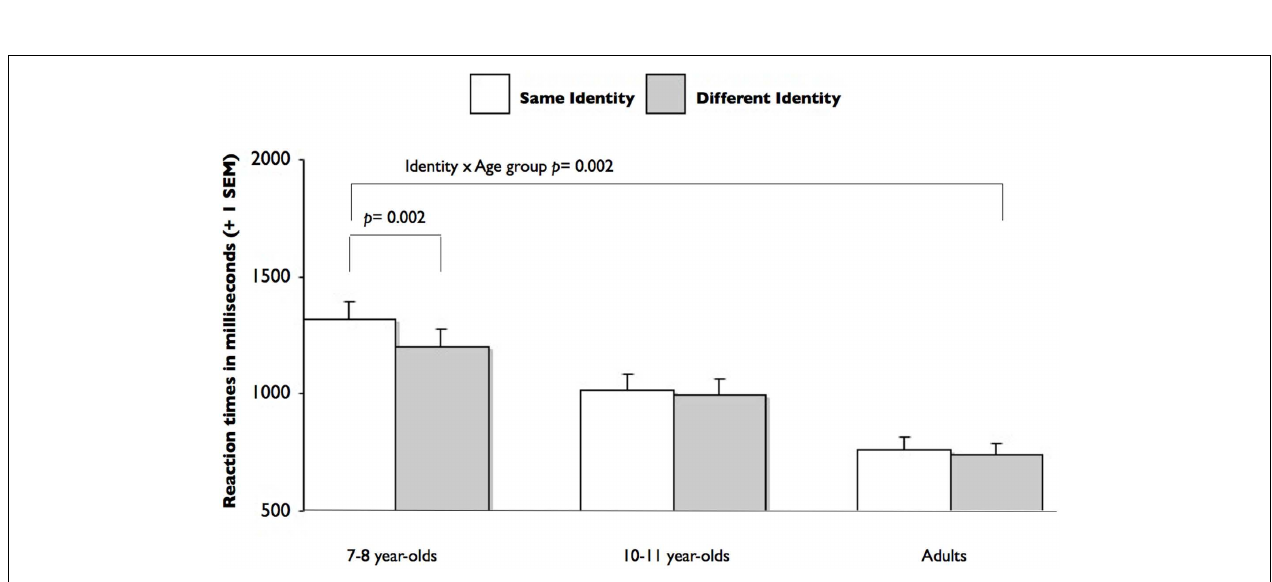
FIGURE 4 | Experiment 2: three-way interaction for identity × expression × gaze for the reaction times for all three age groups. Additional parentheses highlight significant F -tests (interactions and main effects, not t -tests). Diff, different; Express, expression; ID, identity.